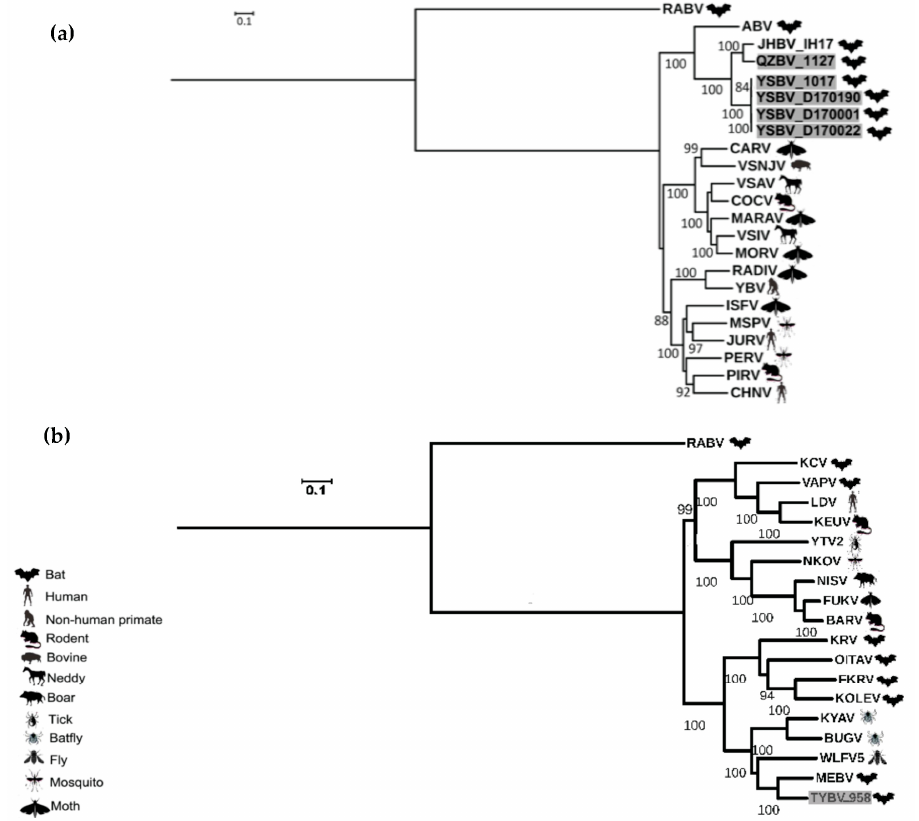
Figure 4. Phylogenetic classification of the six Chinese bat rhabdoviruses. A maximum likelihood phylogenetic tree was done with PhyML3.0 on the nucleotide complete genome sequences, including representative members of the Vesiculovirus genus ( a ) and of the Ledantevirus genus ( b ), using the GTR+G+I model with a bootstrap of 1000 replicates. The main animal reservoirs for each virus are indicated by specific cartoons and the Chinese bat rhabdoviruses described in this study are indicated in grey. All bootstrap proportion values (BSP) > 80% are specified. Scale bar indicates nucleotide substitutions per site.